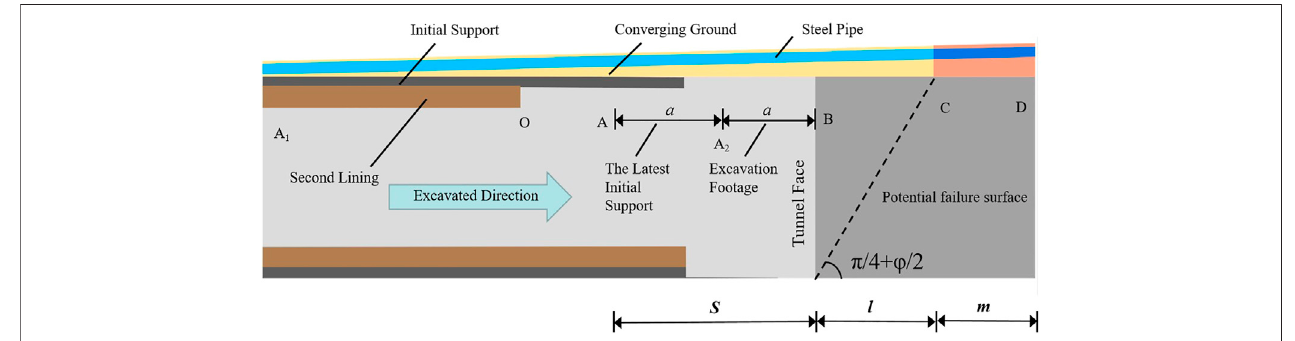
FIGURE 3 | Schematic diagram of tunnel excavation and pipe-roof layout.